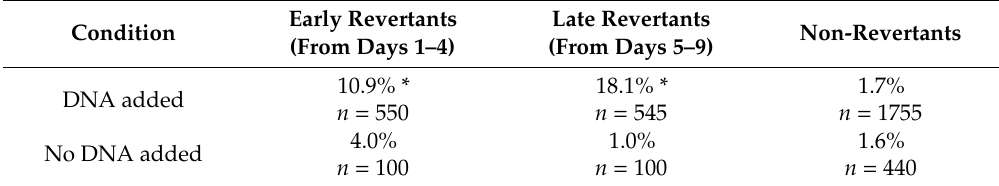
Table 3. Percentage of stationary-phase revertants that were resistant to